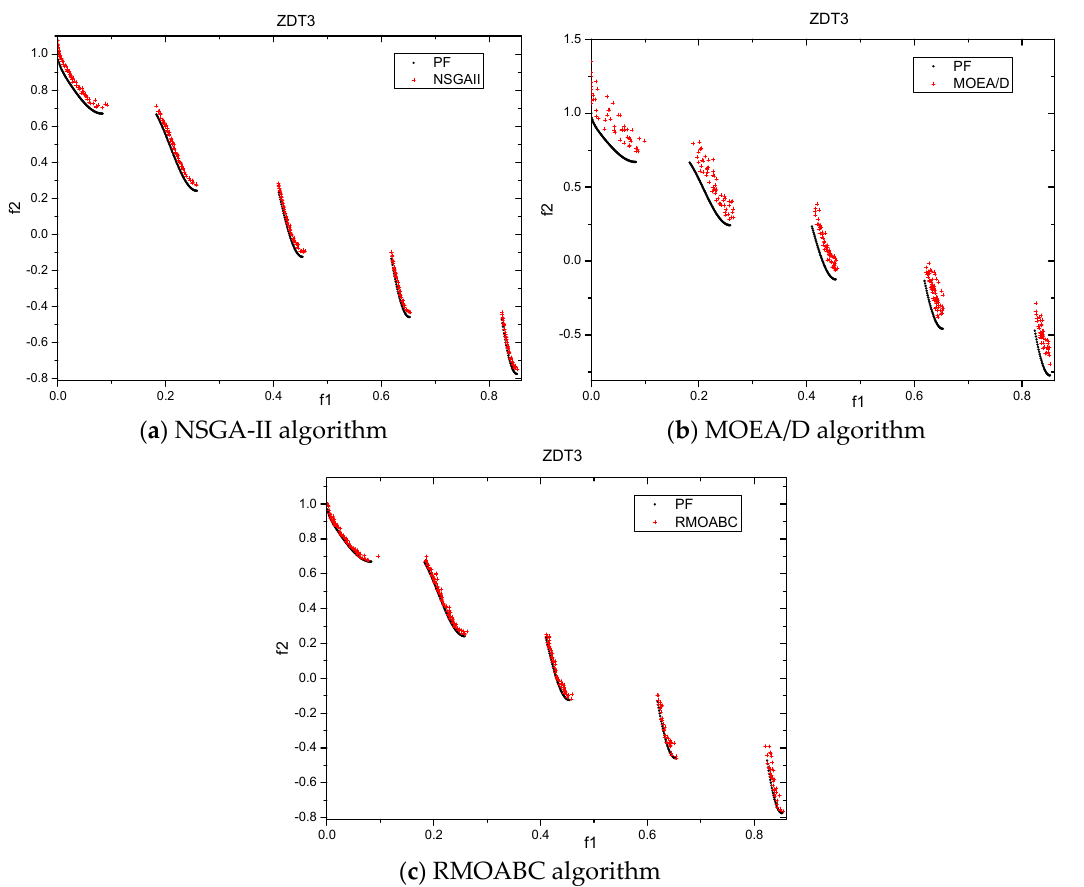
Figure 4. Plots of the non-dominated front found by the three algorithms for 2-objective ZDT3 test instance. ( a ) NSGA-II algorithm; ( b ) MOEA/D algorithm; ( c ) RMOABC algorithm.